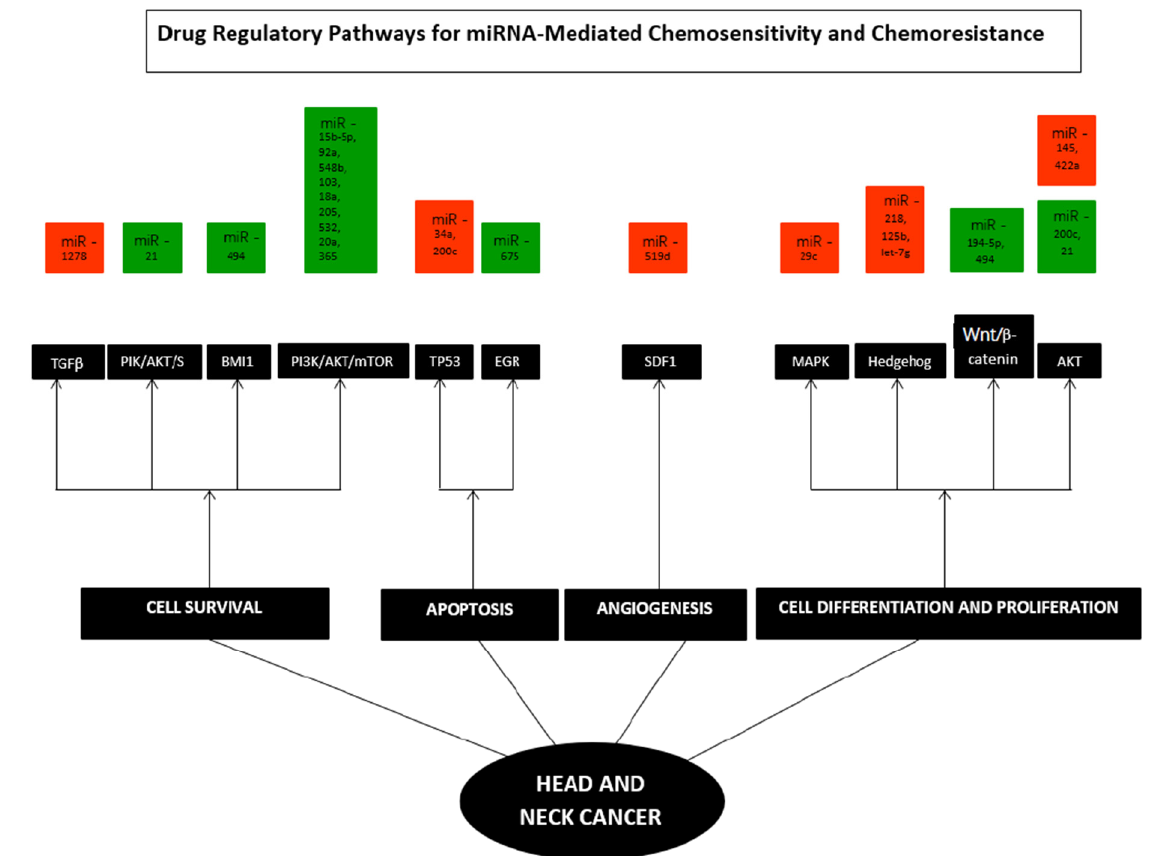
Figure 4. Hallmarks of specific miRNAs in Head and Neck Cancer. TGF β , PIK/AKT/S6, BMI1, PI3K/AKT/mTOR, TP53, EGR, SDF1, MAPK, Hedgehog, Wnt/ β - catenin, and AKT pathways. Each hallmark depicts several examples of miRNAs that control specific cellular processes in HNC; some microRNAs influence multiple hallmarks, implying that they govern various pathways. Orange —down-regulated miRNA; Green —up-regulated